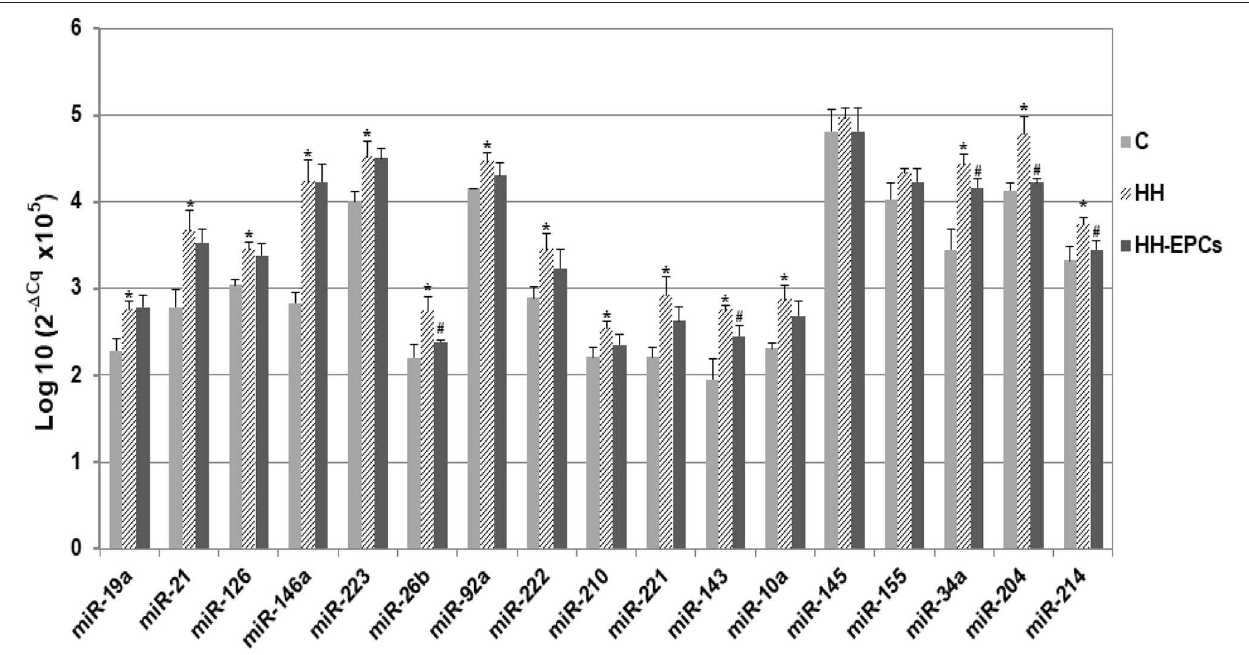
FIGURE 1 | The quantification of 17 circulating miRNA expressions in plasma obtained from hamster groups: control (C), hypertensive-hyperlipidemic (HH), and HH treated with EPCs (HH-EPCs). Data were expressed as log-transformed values of individual 2 − 1 Cq values ( 1 Cq = Cq has-miRNA-Cq cel-miR-39), multiplied to obtain a positive values distribution; The statistically significant differences between the groups were calculated, and represented as * p ≤ 0.05 for values vs. C group, and as # p ≤ 0.05 for values vs. HH group (one way ANOVA